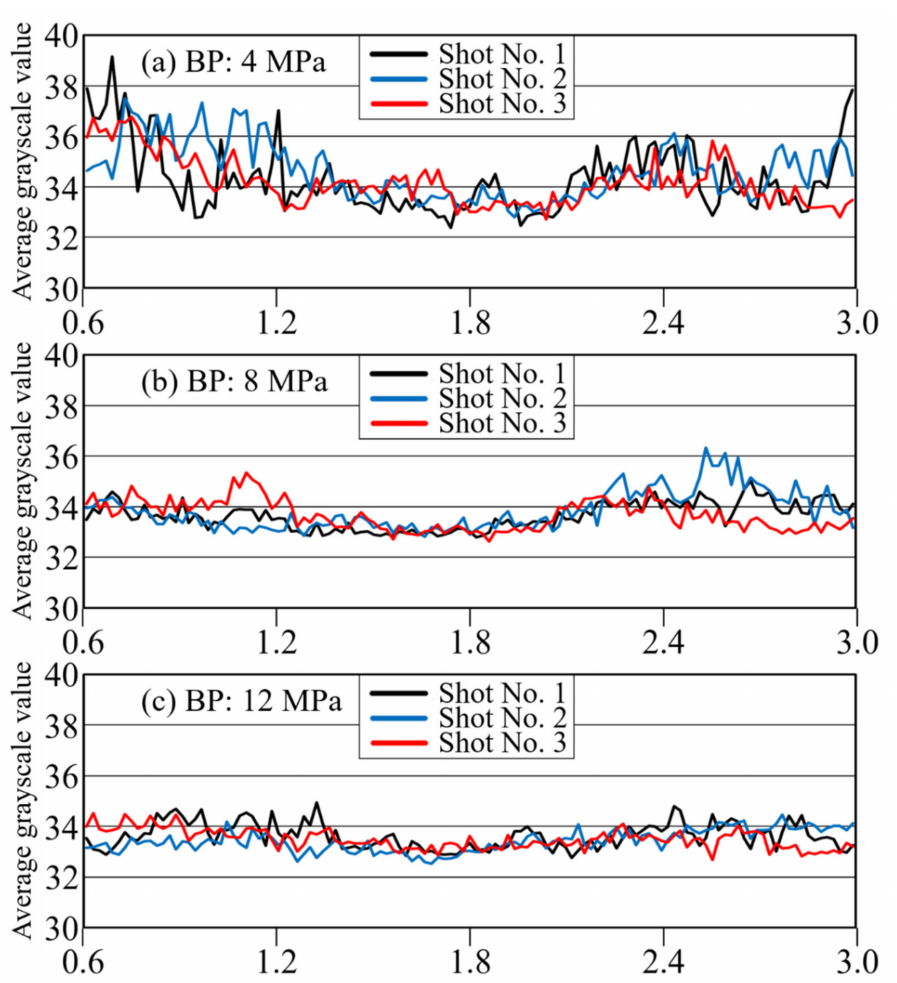
Figure 11. Change curves with time of average grayscale under BP of ( a ) 4 MPa, ( b ) 8 MPa, and ( c ) 12 MPa (CFRP, 10 wt